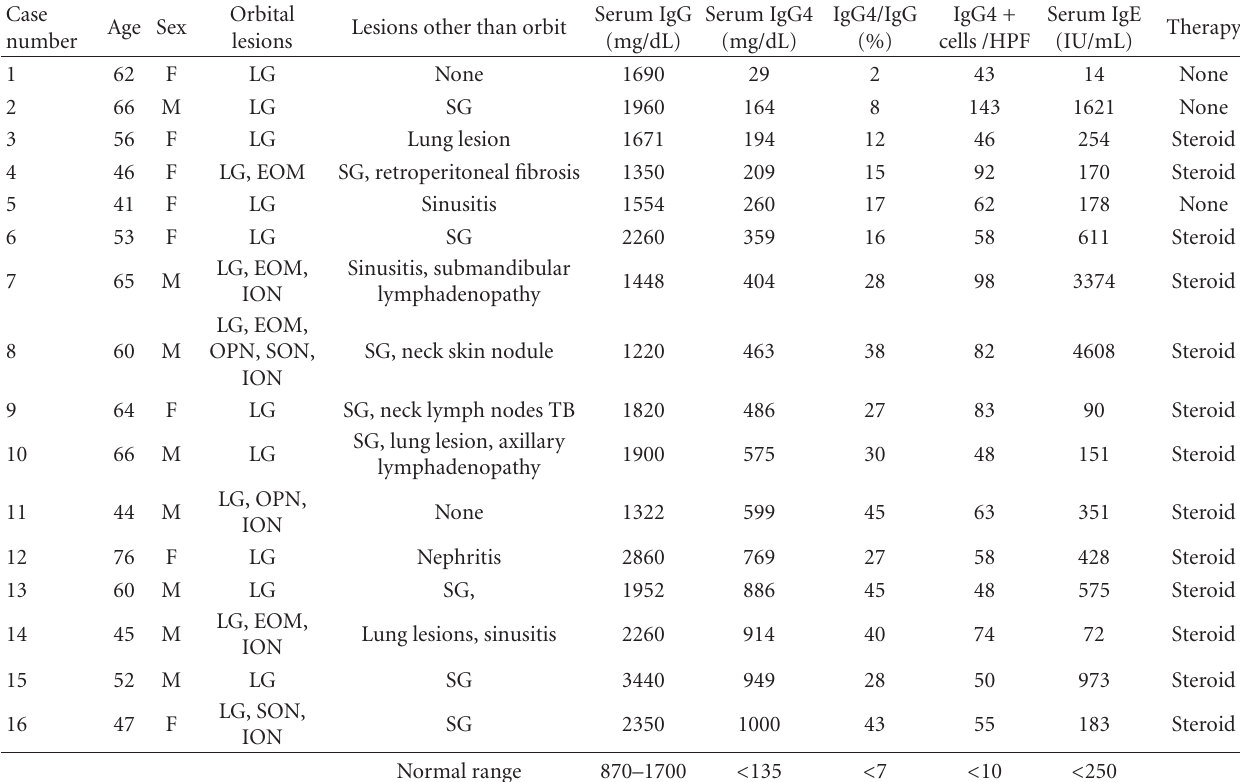
Table 1: Clinical data in 16 cases with IgG4-related orbital